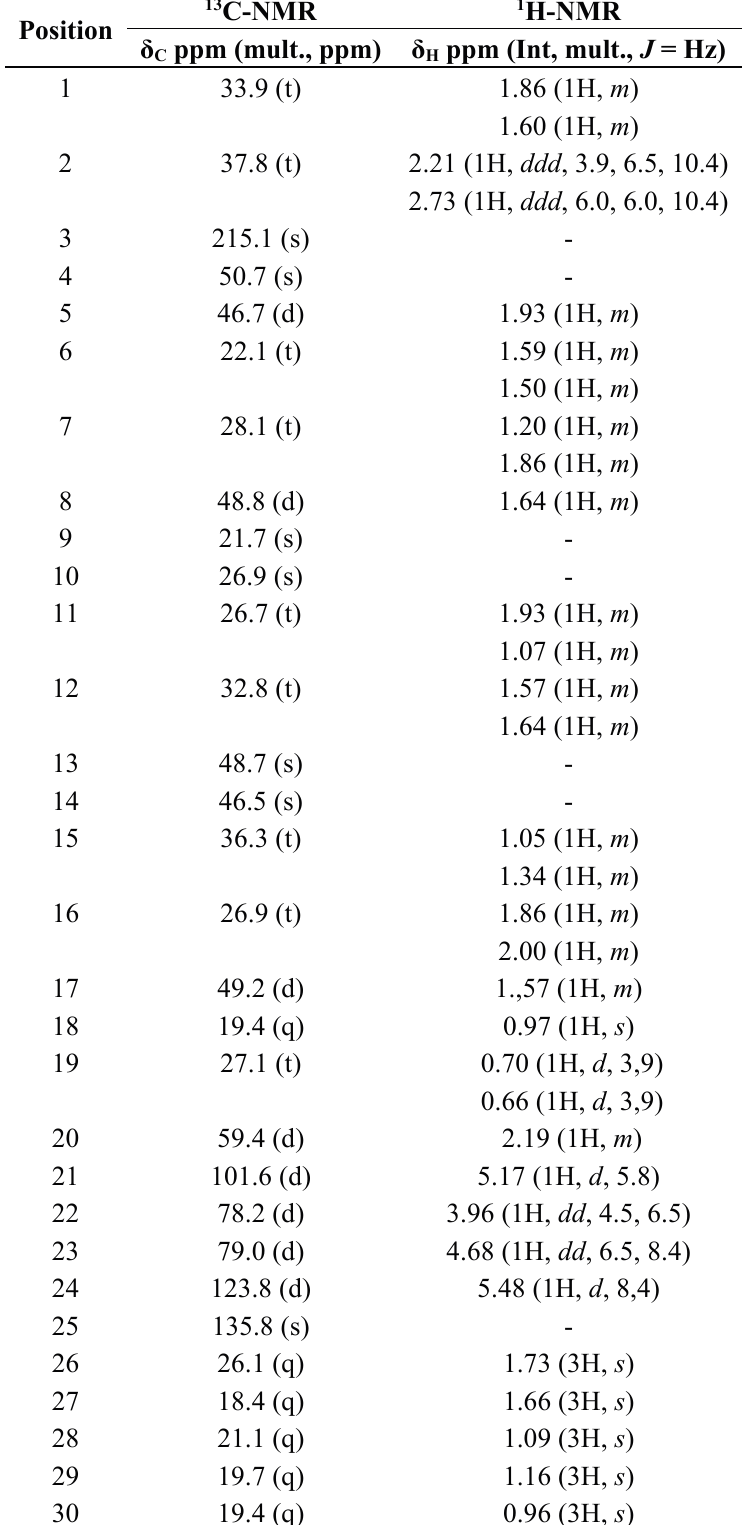
Table 1. NMR data (500 MHz for 1 H and 125 MHz for 13 C, in acetone- d 6 ) for 1 . 13 C-NMR 1 H-NMR Position δ ppm (mult., ppm) δ ppm (Int, mult., J = C H